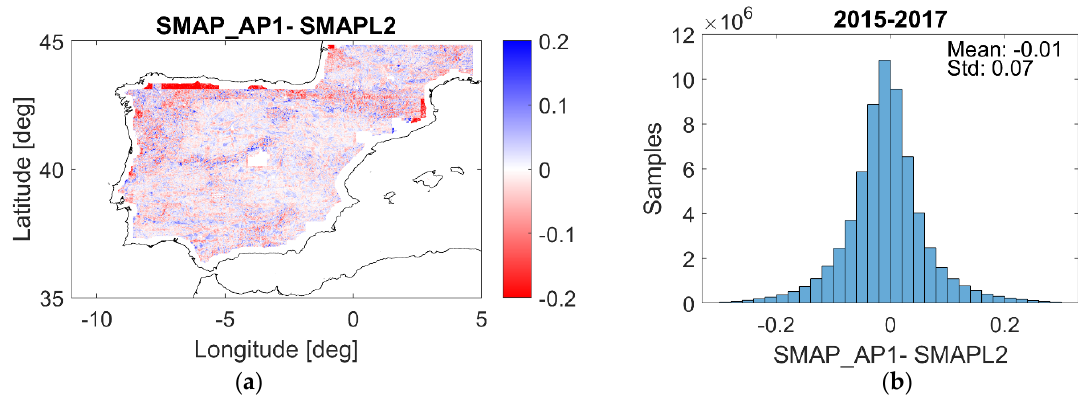
Figure 8. Temporally-averaged map ( a ) and histogram ( b ) of daily SMAP SSM differences (SMAP_AP1 at 1 km minus SMAPL2 at 36 km), for the period April 2015 to December 2017. Remote Sens. 2020 , 12 , x FOR PEER REVIEW